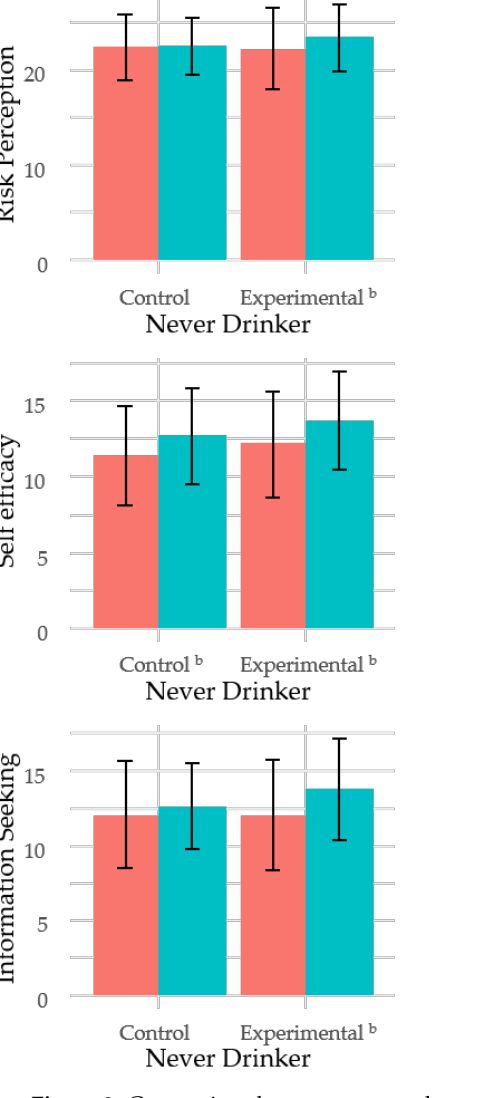
Figure 2. Comparison between pre- and post-test scores stratified by drinking habits. a The p -values represent the score differences between the pre- and post-tests. b p < 0.05